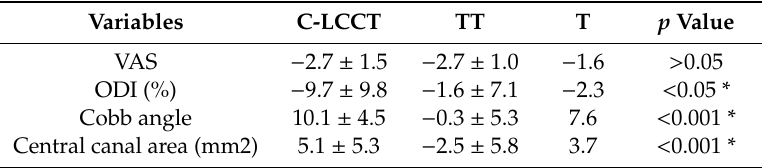
Table 4. Comparison of changes between C-LCCT and TT